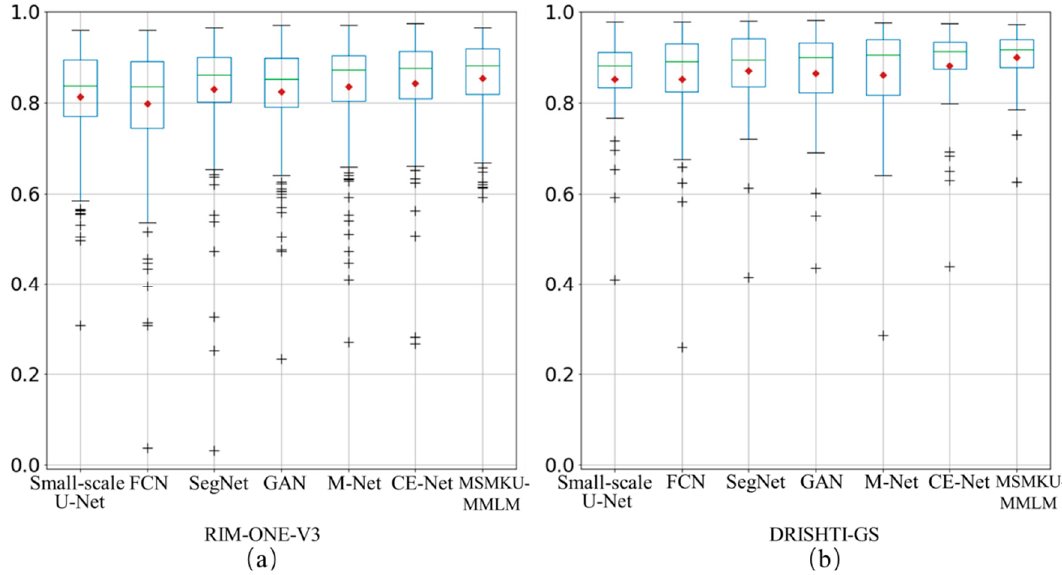
Figure 6. Boxplot of F-score predicted by the proposed and compared methods. ( a ) result on RIM-ONE-V3 dataset ( b ) result on DRISHTI-GS dataset. Table 2. Comparisons with deep learning methods for OD and OC segmentation on RIM-ONE-V3 dataset.